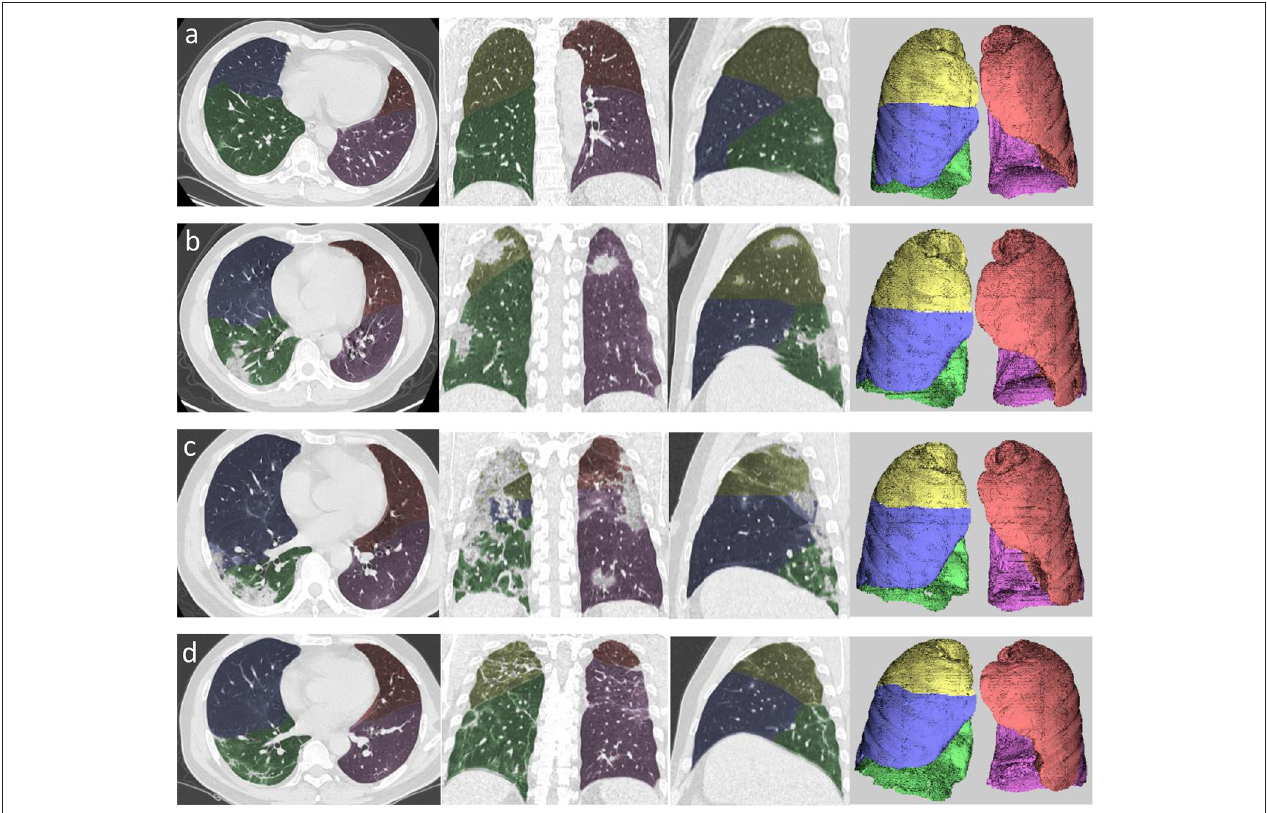
FIGURE 2 | Example of segmentation using automated computer-aided diagnosis in the four stages of COVID-19 pneumonia. (a) Axial, coronal, and sagittal multiplanar reconstruction views and volume rendering in the early stage. (b) Axial, coronal, and sagittal multiplanar reconstruction views and volume rendering (left to right) in the progressive stage. (c) Axial, coronal, and sagittal multiplanar reconstruction views and volume rendering (left to right) in the peak stage. (d) Axial, coronal, and sagittal multiplanar reconstruction views and volume rendering (left to right) in the absorption stage. Yellow area denotes right upper lobe, blue area denotes right middle lobe, green area denotes right lower lobe, orange area denotes left upper lobe, and pink area denotes left lower